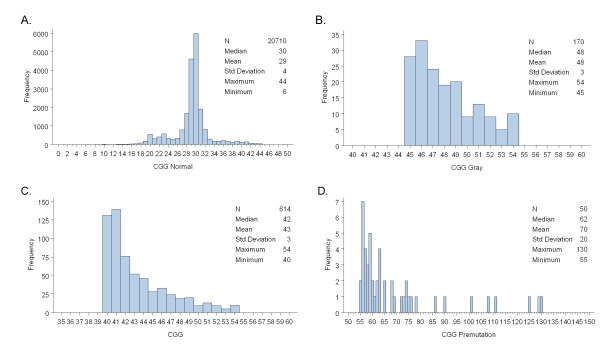
CGG repeat allele size distribution. Histograms display the CGG repeat length observed in the newborn screening by allele category. A) FMR1 alleles in the normal range (<45 CGG repeats, n = 20710 alleles). B) FMR1 alleles in the gray zone range (45-54 CGG repeats, n = 170 alleles). C) FMR1 alleles in the expanded gray zone range (40-54 CGG repeats, n = 614 alleles). D) FMR1 alleles in the premutation range (55-200 CGG repeats, n = 50).